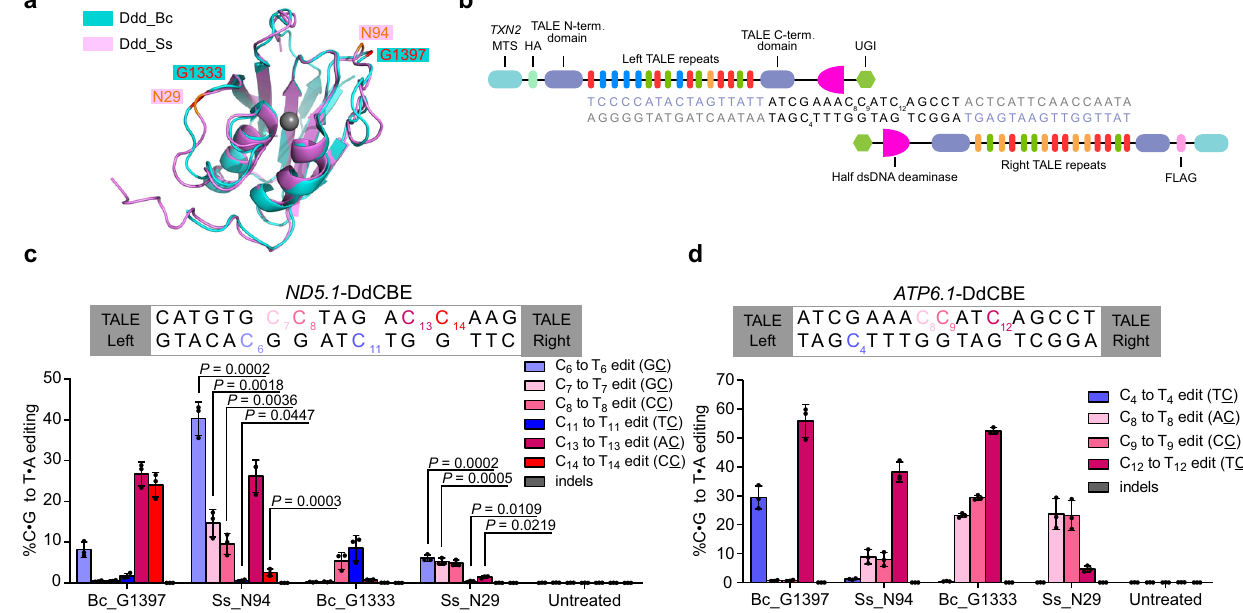
Fig. 2 | DdCBE_Ss achieve high-ef fi ciency editing at multiple mtDNA loci. a Structural alignment of Ddd_Bc (blue, PDB 6U08) and Ddd_Ss (purple, predicted by ColabFold). Ddd_Bc was split after the red-labeled amino acid G1333 or G1397, Ddd_Ss was split after the orange-labeled amino acid N29 or N94. b Split deami- nases fused to left and right TALE proteins targeted to the MT-ATP6 gene. c , d mtDNAeditingef fi cienciesandindelfrequenciesofHEK293Tcellstreatedwith